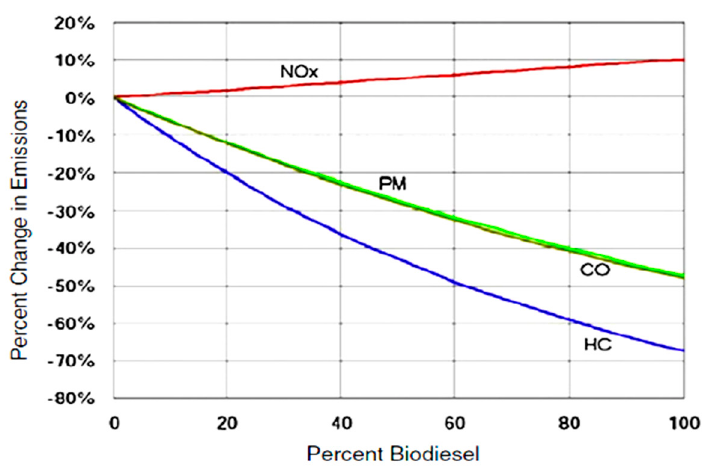
ff ect on greenhouse gas emissions Figure 7. Biodiesel percentage effect on greenhouse gas emissions [47]. Figure 7. Biodiesel percentage e